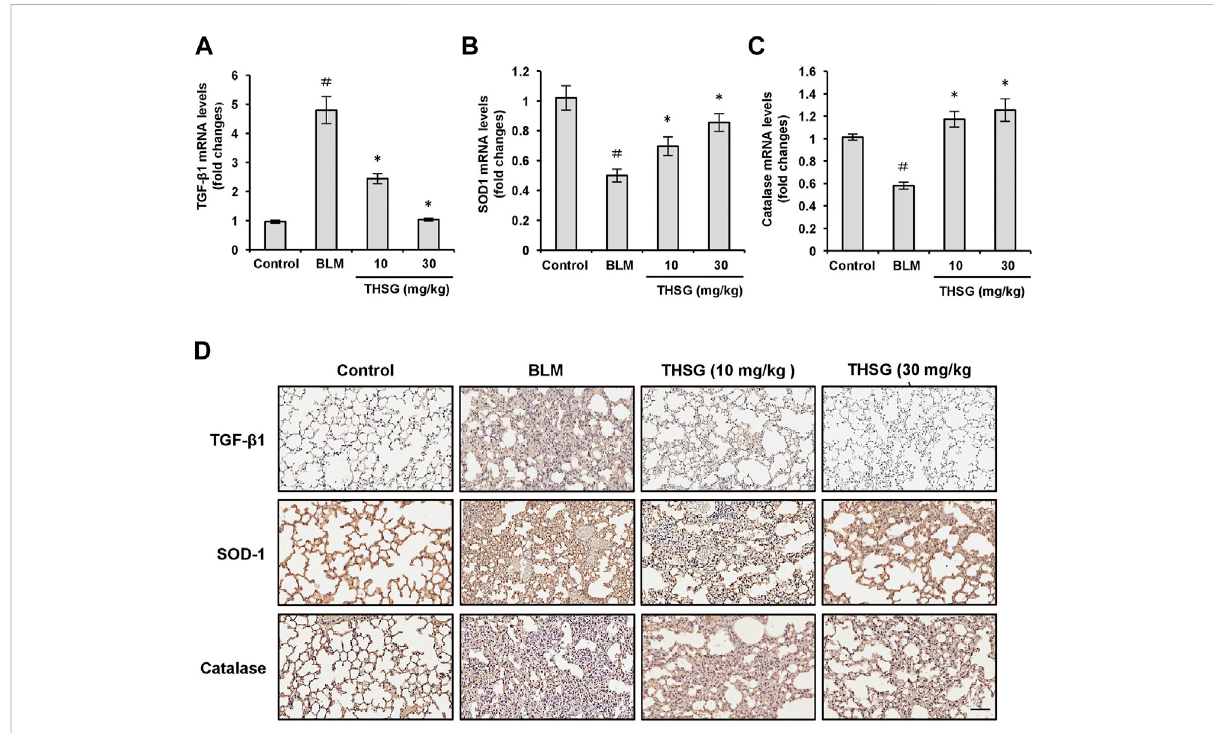
FIGURE 5 Effect of THSG on TGF- β 1, SOD-1, and catalase expression in the lung tissues of BLM-stimulated mice. The mRNA levels of TGF- β 1 (A) , SOD-1 (B) , and catalase (C) in the lung tissues of mice from each group on day 21 were detected by the qRT-PCR. (D) Representative photographs of immunohistochemical staining for TGF- β 1, SOD-1, and catalase in the lung sections of mice from different experimental groups. Scale bar: 100 μ m. Data are represented as the mean ± SEM ( n = 6 in each group ). # p < 0.05 compared with vehicle-treated control group. * p < 0.05 compared with BLM